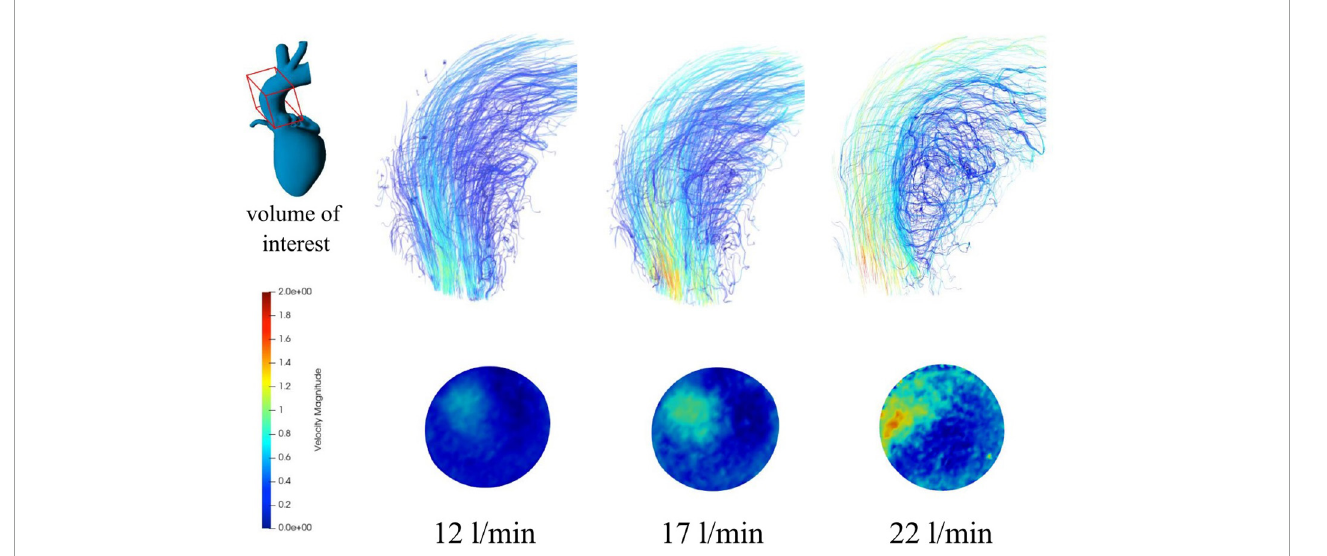
FIGURE5 Streamlines (top) and contour maps (bottom) for continuous antegrade flow rates of 12, 17, and 22 l/min.